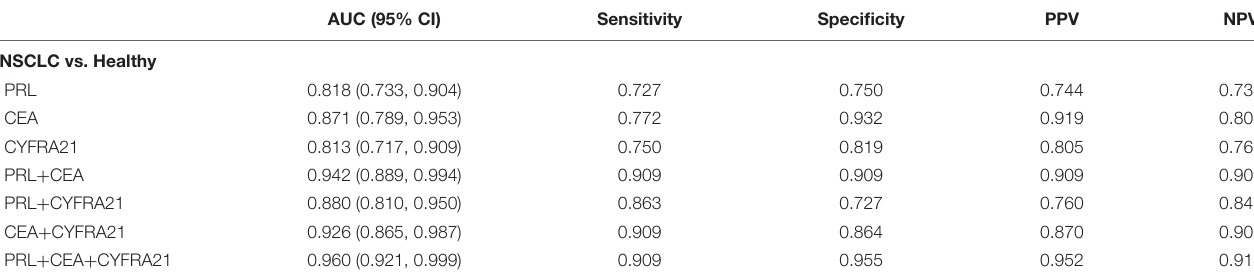
TABLE 2 | Diagnostic efficiency of models in differentiating NSCLC from the healthy